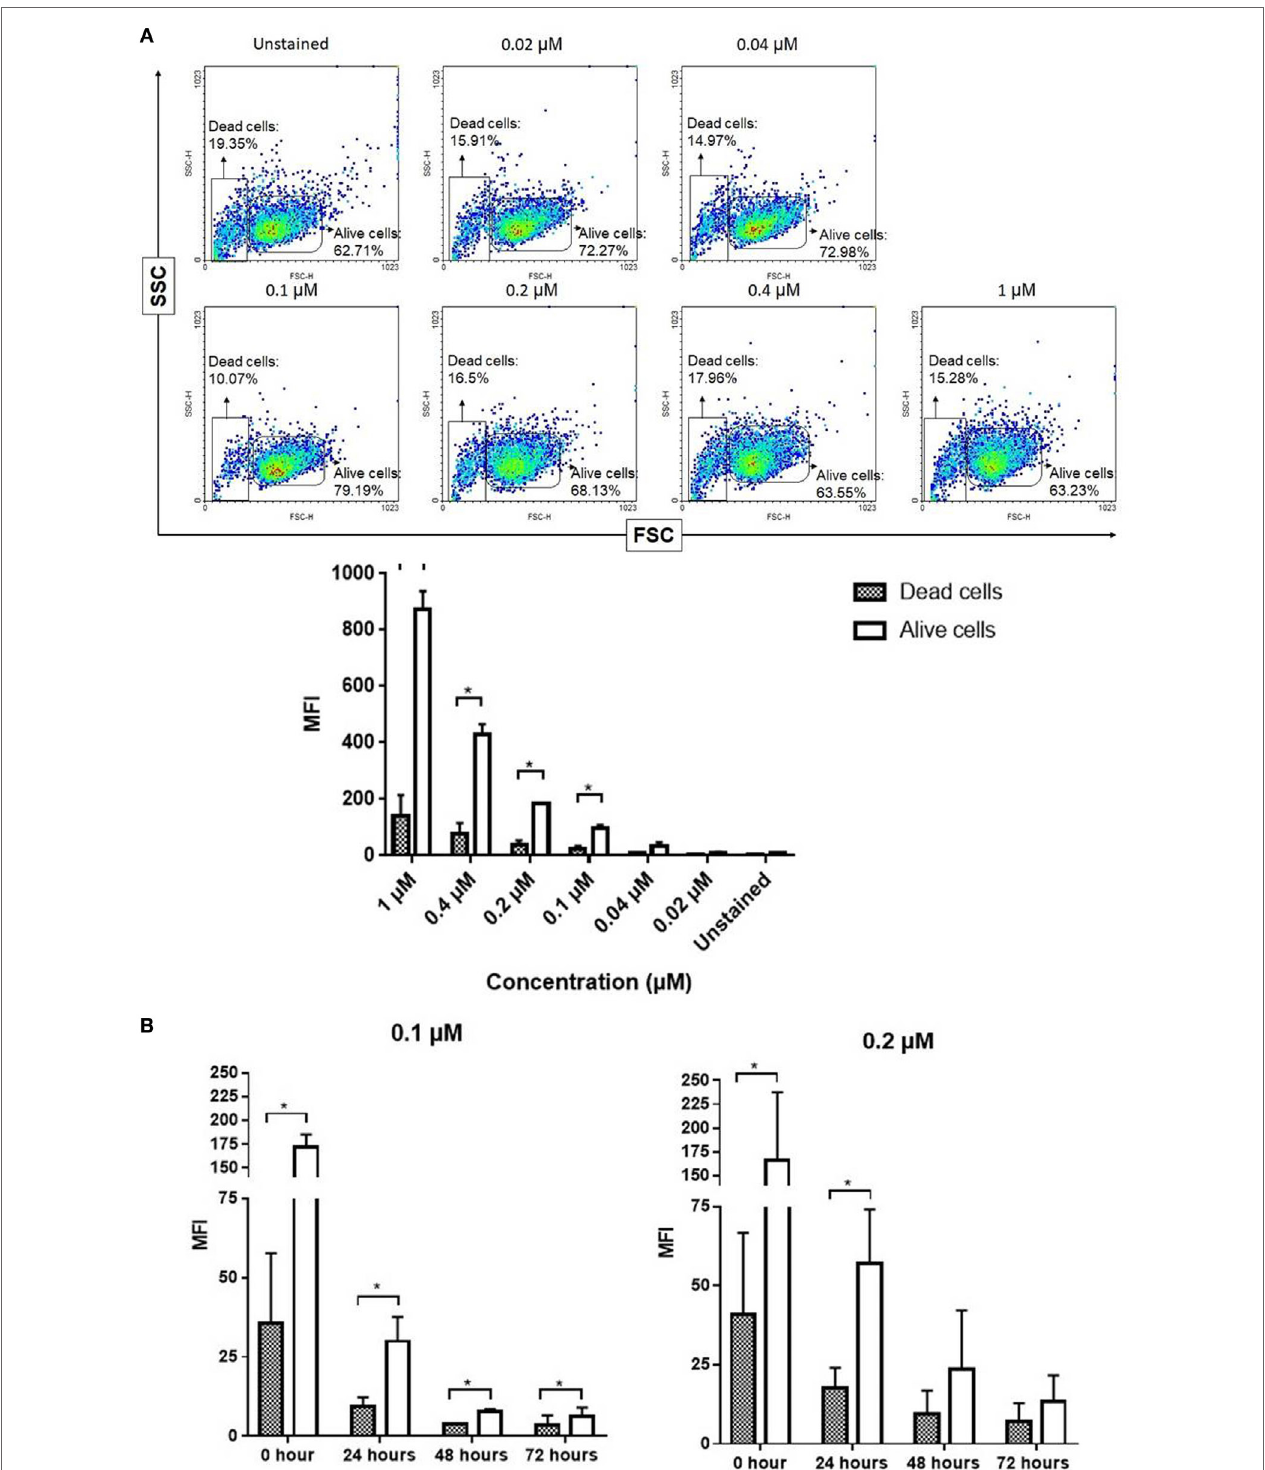
FigUre 3 | Fluorescent signal intensity between alive and dead natural killer (NK) cells stained ESNF13. (a) Expanded NK cells were stained with different concentrations of ESNF13 and the dye intensity of alive and dead cell populations were analyzed by flow cytometry immediately after staining. Representative flow cytometry density plots (top) and the mean fluorescent intensity values (bottom). (B) Expanded NK cells were stained with ESNF13 and the dye intensity of alive and dead cell populations assessed using flow cytometry was compared in a time-dependent manner. The bar diagrams represent the mean fluorescent intensity values. Data represent the mean ± SD from three independent experiments. Asterisk (*) indicates p < 0.05 in paired sample t -test